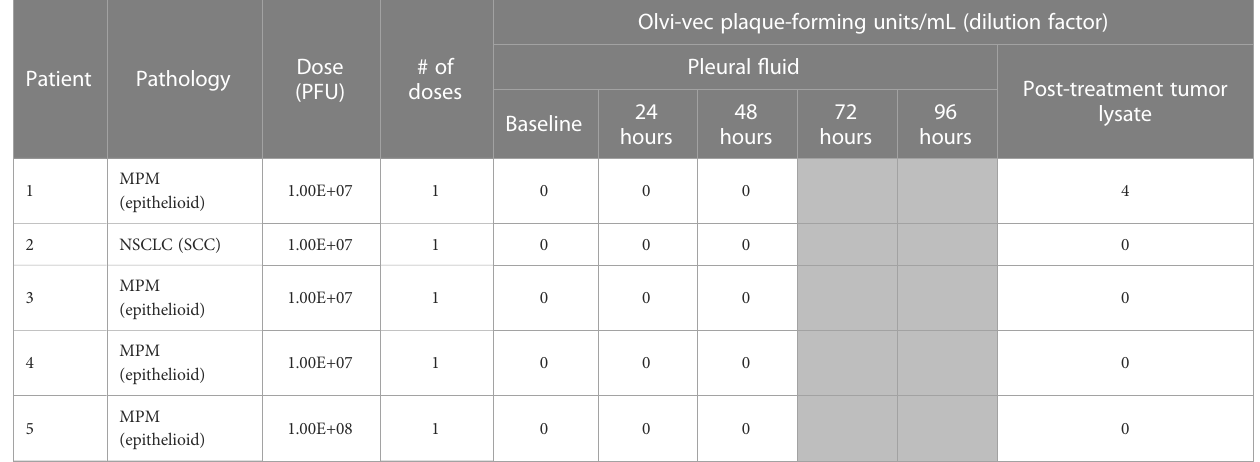
TABLE 4A Results of viral plaque assay (pleural fl